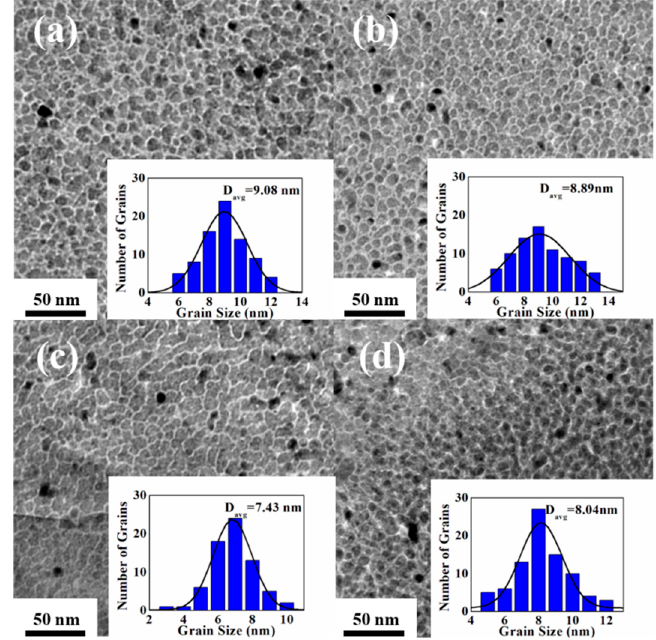
Figure 5. The plan-view TEM images of the FePt(BN, Ag, C)( x vol.%)/MoC( y nm)/MgTiON/CrRu/glass films, ( x , y ) = ( a ) (0, 0), ( b ) (10, 0), ( c ) (0, 3), ( d ) (10, 3).